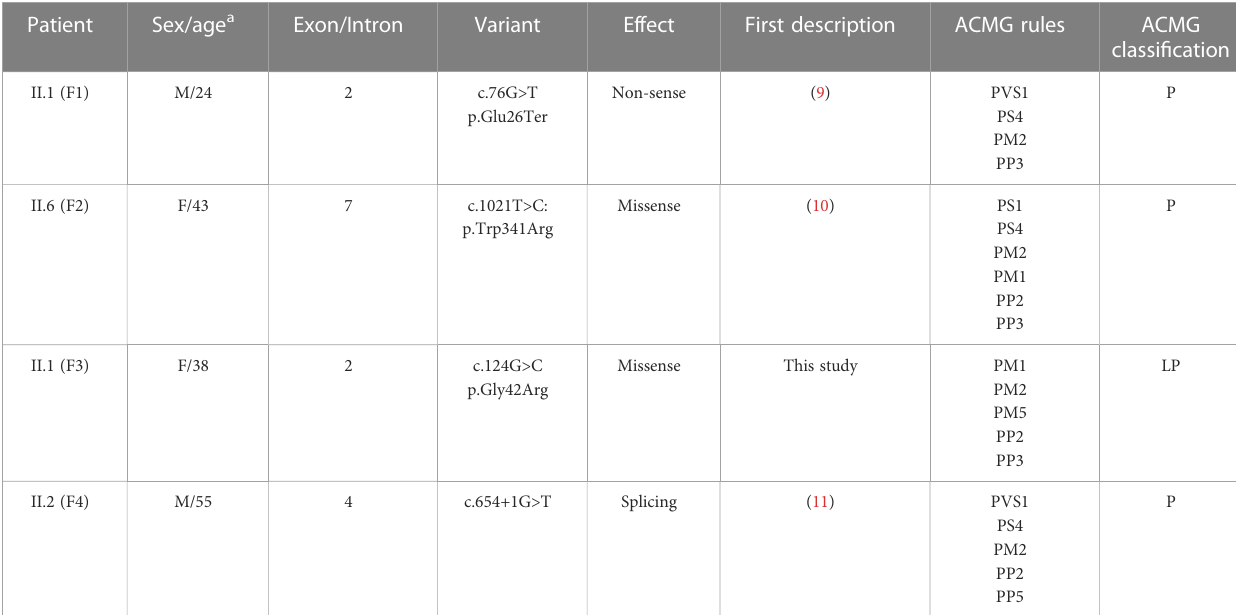
TABLE 2 Mutation analysis of each family with MEN1